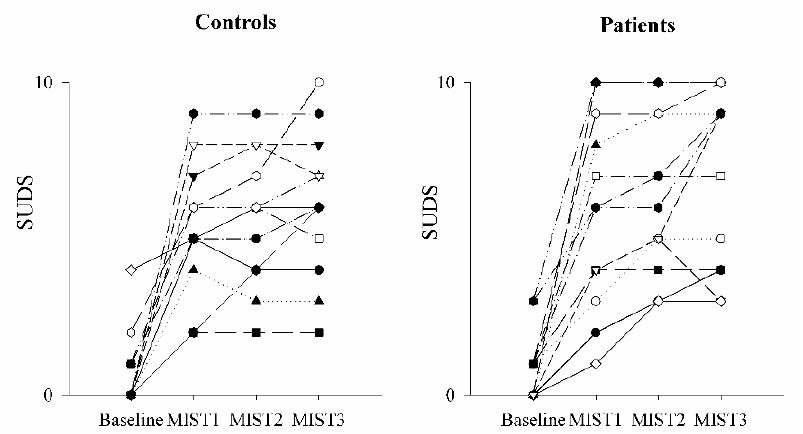
Figure 2. Trend of the SUDS scale scores as a function of the experimental sessions in controls and PAH patients. The scatterplots show the Subjective Units of Distress Scale (SUDS) scores in healthy controls ( left panel) and in PAH patients ( right panel) at the end of the resting condition (Baseline) and after each of the three different blocks of the Montreal Imaging Stress Test (MIST1, MIST2 and